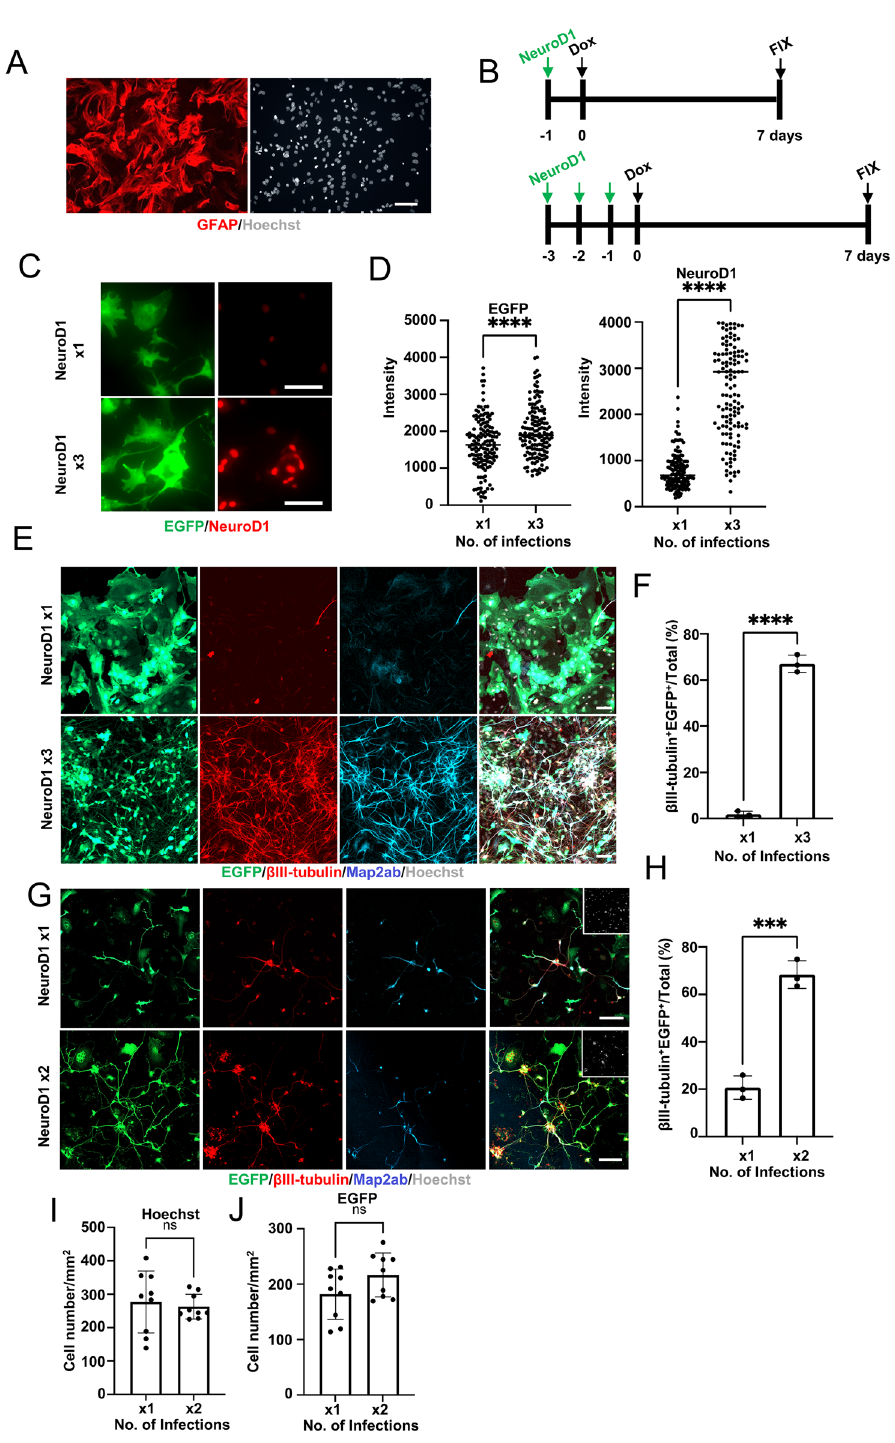
Figure 2. Conversion efficiency is promoted with increased RF expression level. ( A ) Representative images of non-reactive astrocytes (NR-astrocytes) stained for the astrocyte marker GFAP (red). Scale bar, 75 μm. ( B ) Scheme of single or multiple (three times) infection of NR-astrocytes with three viruses (EGFP-, M2rtta-, and NeuroD1-viruses; indicated as NeuroD1). ( C ) Representative images of staining for EGFP (green) and NeuroD1 (red) in NeuroD1-transduced NR-astrocytes at 2 dpt. Dox, 1 μg/mL. Scale bars, 75 μm. × 1 and × 3 indicate number of viral infections. ( D ) Fluorescence intensity of EGFP or NeuroD1 in ( C ). **** p < 0.0001 by unpaired Student’s t test. ( E ) Representative images of staining for EGFP (green), βIII-tubulin (red), and Map2ab (cyan) in reprogrammed neuronal cells from NR-astrocytes at 7 dpt. Dox, 1 μg/mL Dox. Scale bars, 100 μm. × 1 and × 3 indicate number of viral infections. ( F ) Quantification of the βIII-tubulin and EGFP + cells in ( D ) (n = 3). **** p < 0.0001 by unpaired Student’s t test. ( G ) Representative images of staining for EGFP (green), βIII-tubulin (red), and Map2ab (cyan) in reprogrammed neuronal cells from microglia at 7 dpt. Dox, 1 μg/mL. Scale bars, 100 μm. × 1 and × 2 indicate number of viral infections. ( H ) Quantification of the βIII-tubulin and EGFP + cells in (F) (n = 3). *** p < 0.0005 by unpaired Student’s t test. ( I ) Quantification of the number of Hoechst + cells per mm 2 in NeuroD1-transduced microglia. × 1 and × 3 indicate number of viral infections. (n = 3). ns means not significant. ( J ) Quantification of the number of EGFP + cells per mm 2 in NeuroD1-transduced microglia. × 1 and × 3 indicate number of viral infections. (n = 3). ns means not